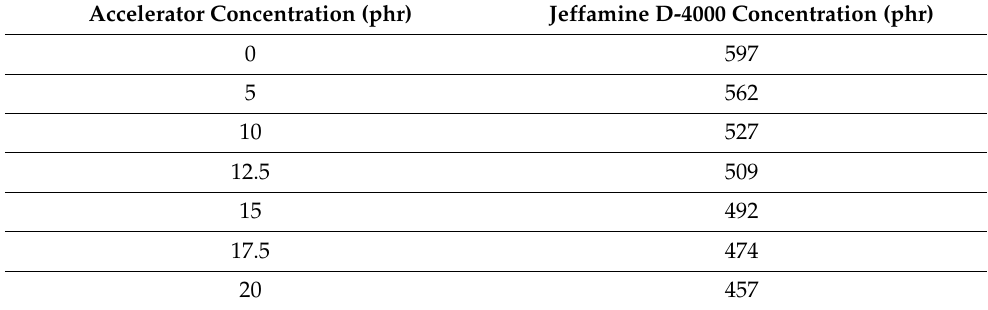
Table 1. Accelerator and hardener